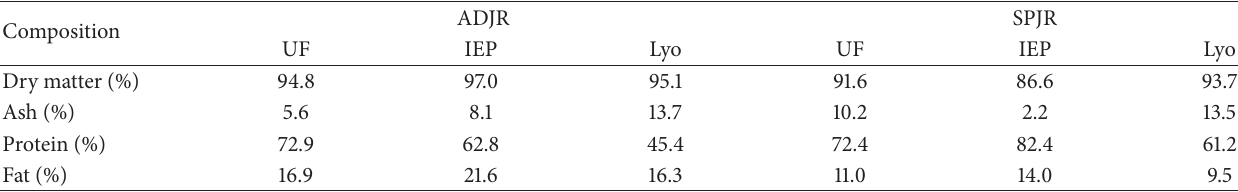
Table 1: Composition of the Jatropha protein products obtained after extraction of aqueous extracted (ADJR) and screw-pressed Jatropha residue (SPJR) applying different methods for protein recovery (unpublished data Fraunhofer IVV). ADJR SPJR Composition UF IEP Lyo 94.8